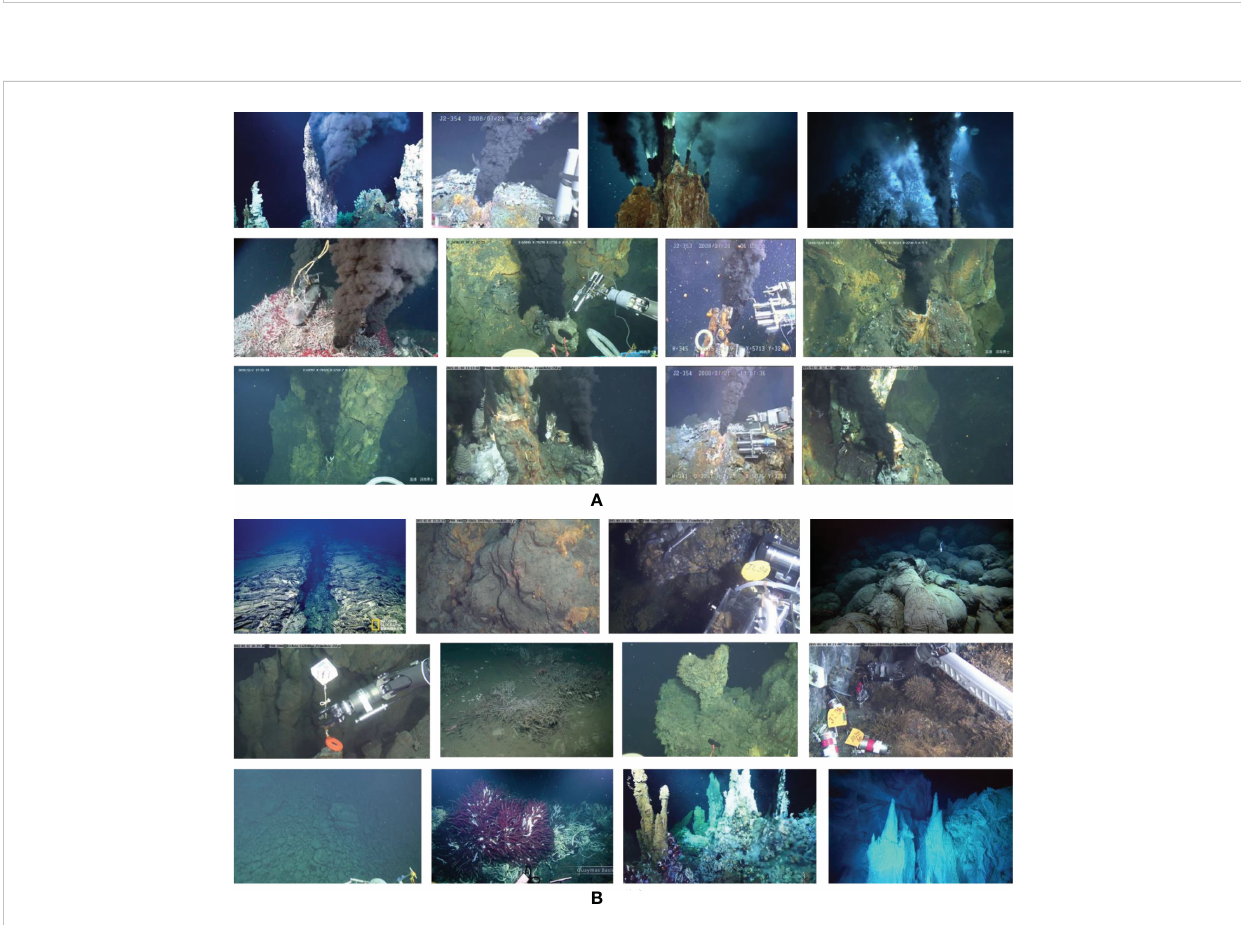
FIGURE 2 Example images from the deep-sea hydrothermal plume dataset: (A) images of hydrothermal plume; (B) images of deep-sea